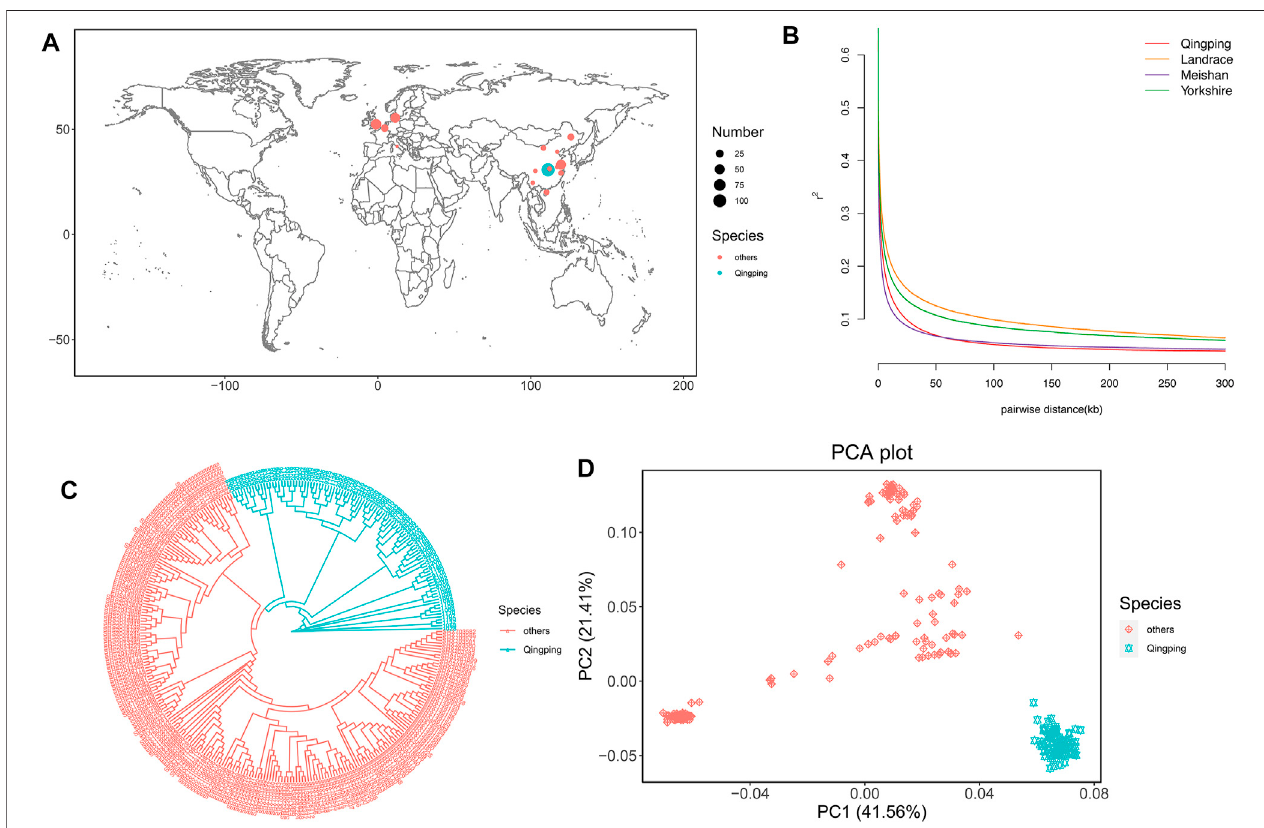
FIGURE1| Populationanalyses. (A) Geographicdistributionofthe319pigs.QPpigsand15otherbreedsarerepresentedbyblueandpinkdotsontheworldmap, respectively. The sample size is represented by the dot size. (B) LD decay of QP and downloaded breeds. (C) NJ tree of the 319 pigs. QP pigs and 15 other breeds are represented by blue and pink lines, respectively. (D) Plots of PC1 and PC2 for the 319